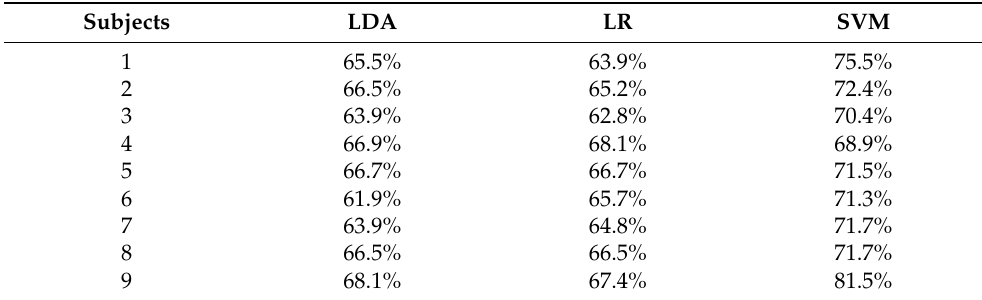
Table 3. Subject-wise classification accuracies of all subjects (%) were obtained by extracting features (i.e., SM. SP, and SV) of HbO signals and classification using SVM, LDA, and LR of the walking and resting states (binary classification) of 9 subjects.